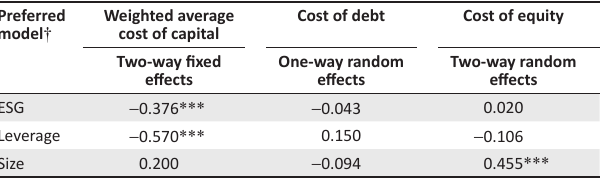
TABLE 5: Regression results for the composite environmental, social and corporate governance disclosure scores for the consumer services sector. Preferred model †